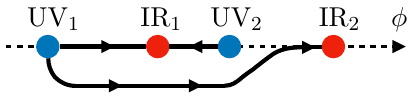
Figure 4 . Schematic structure of a (cid:12)eld theory which presents multiple RG-(cid:13)ows: in particular, there are two (cid:13)ows starting at the (cid:12)xed point UV 1 , one going to the closer IR (cid:12)xed point IR 1 , the second skipping IR 1 and ending at IR 2 . On the other hand there is no (cid:13)ow from UV 2 to IR 2